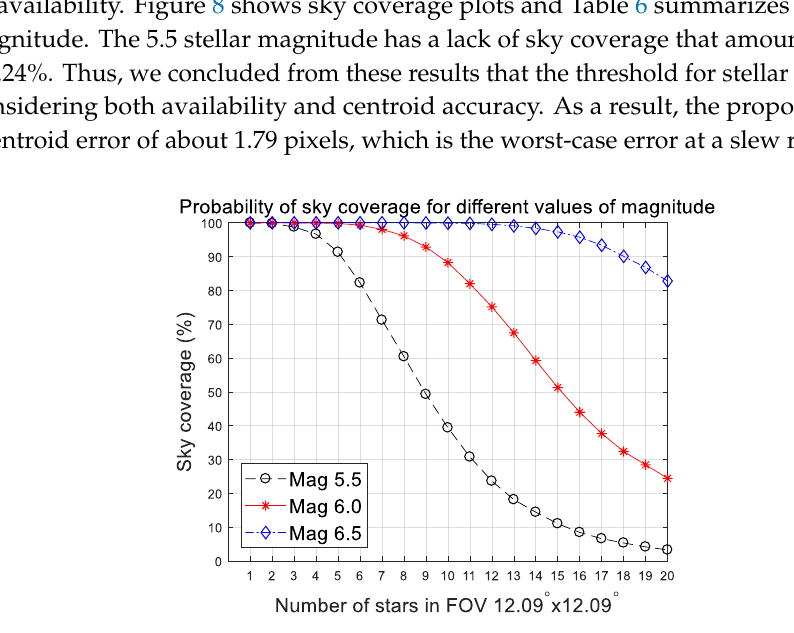
Figure 8. Probability of sky coverage in a 12.09° × 12.09° field of view (FOV) for different stellar magnitudes. Table 6. Probability of availability of at least six